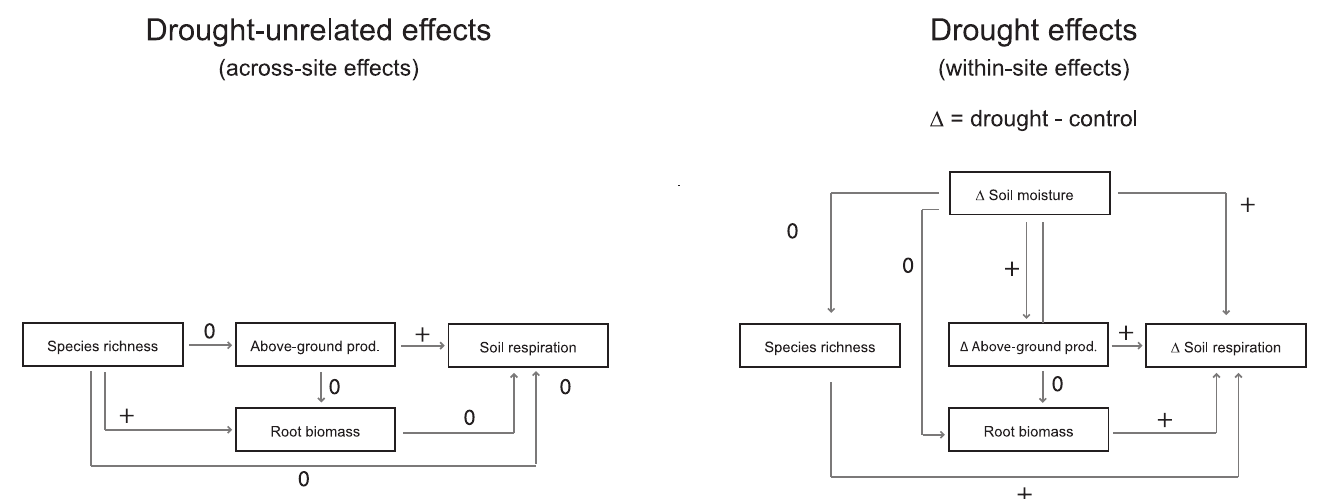
Fig 5. Interactions of biotic drivers with soil respiration and its response to drought. Schematic illustration of the interaction of the investigated biotic drivers (i.e. annual above-ground productivity, species richness and root biomass) with soil respiration irrespective of the drought treatment (left) and with the drought response of soil respiration (right). + indicates positive correlations; 0 indicates no significant effect. Note that Δ SR was always calculated as the difference of soil respiration rates between drought and control plots (SR drought—SR control), thus negative Δ SR values depict reduced soil respiration rates due to the drought treatment and the more negative Δ SR, the larger the drought effect on soil respiration. As an example, species richness is positively correlated with Δ SR under drought conditions, which indicates a more positive Δ SR with increasing species richness, i.e. a lower drought effect on SR with increasing species richness.